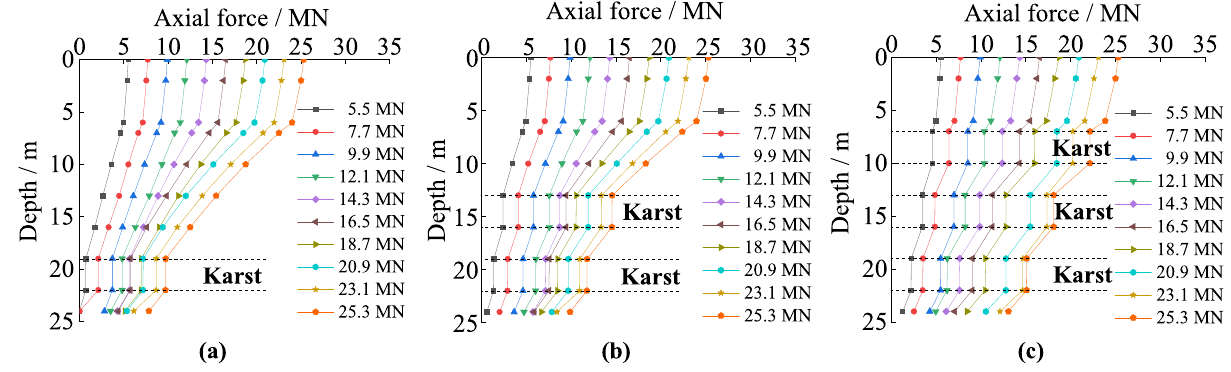
Figure 5. The axial force of piles with different number of karst caves: ( a ) cave’s number is one; ( b ) cave’s number is two; ( c ) cave’s number is three.